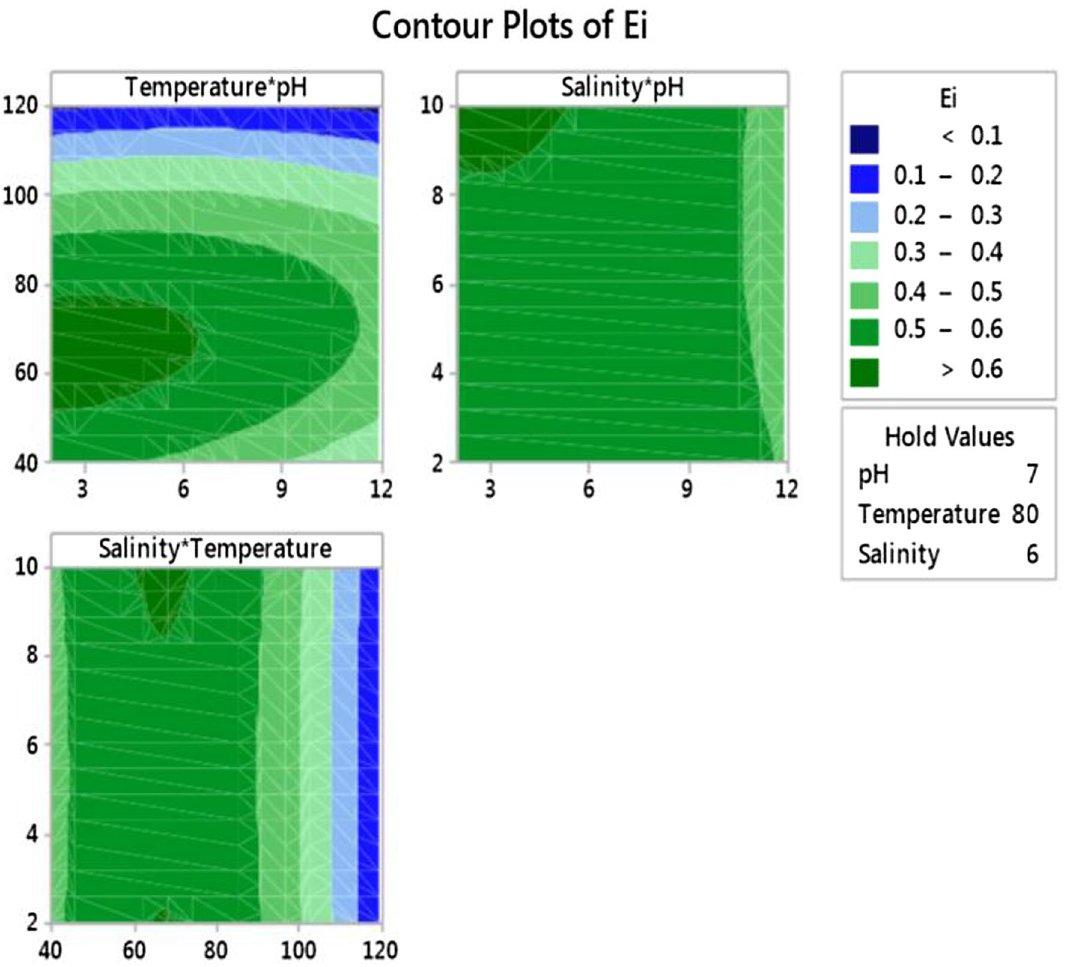
Fig. 5 Contour plots generated from regression model representing interactive effects of pH, temperature, and salinity on biosurfactant stability by Pseudoxanthomonas sp. G3 with light crude oil after 24 h